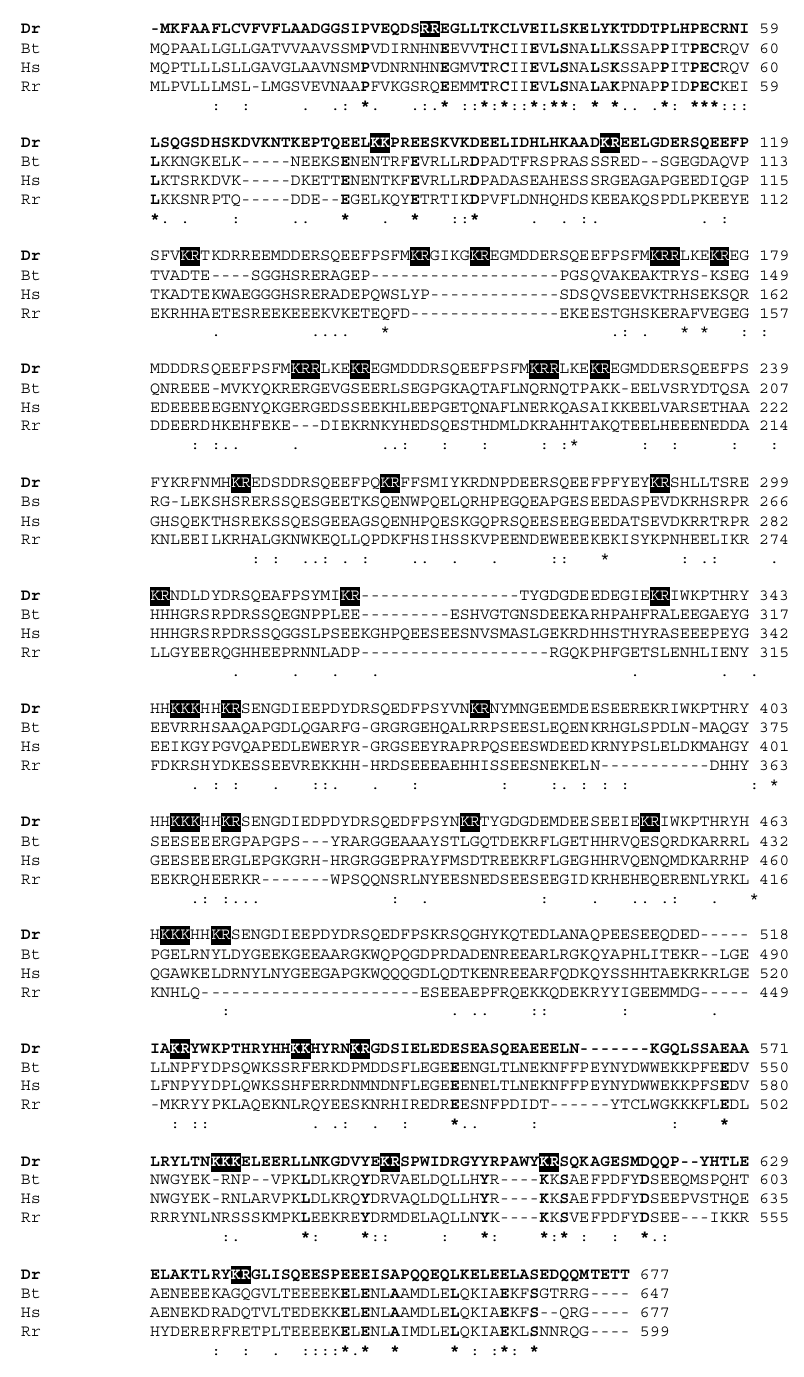
Figure 2. Primary structure CgB of a 677-amino acid mature protein that encompasses 25% acidic residues. The zebrafish (Dr, Danio rerio ) CgB amino acid sequence was aligned with the human, bovine and amphibian sequences (Bt, Bos taurus , Hs, Homo sapiens , Rr, Rana ridibunda ). The amino acids of zebrafish CgB that are conserved in the other species are in bold. The positions of the di- or tribasic residues are indicated by highlight and represent amphiphilic part of the molecule active in antimicrobial interaction. The hyphens represent gaps that have been introduced for the alignment. The amino acid sequence of zebrafish parasin I (zfparasin I; 154 amino acid residues) shows significant homology with the N-terminal region of histone H2A (Table